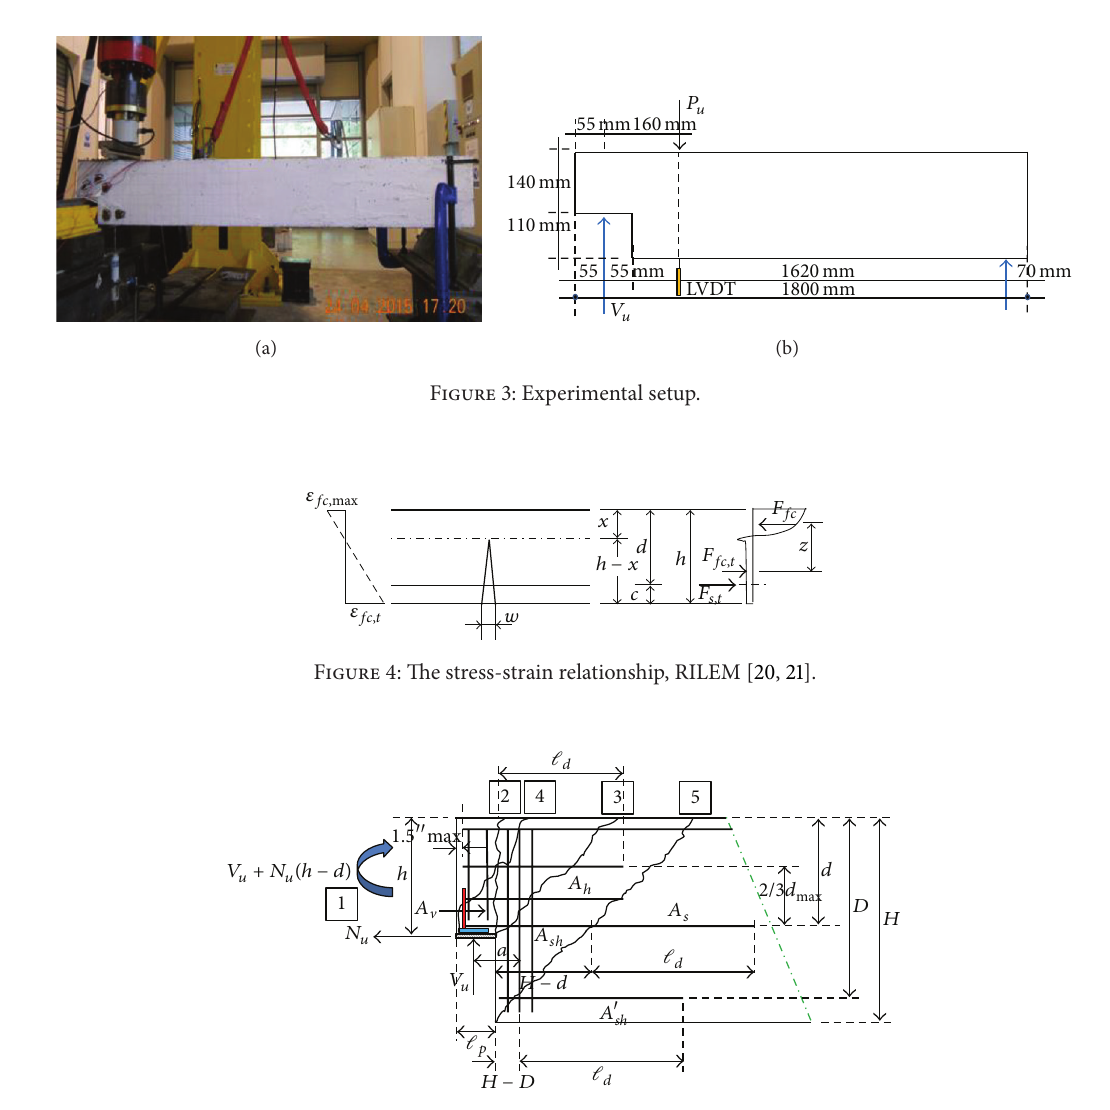
Figure 5: Potential failure modes